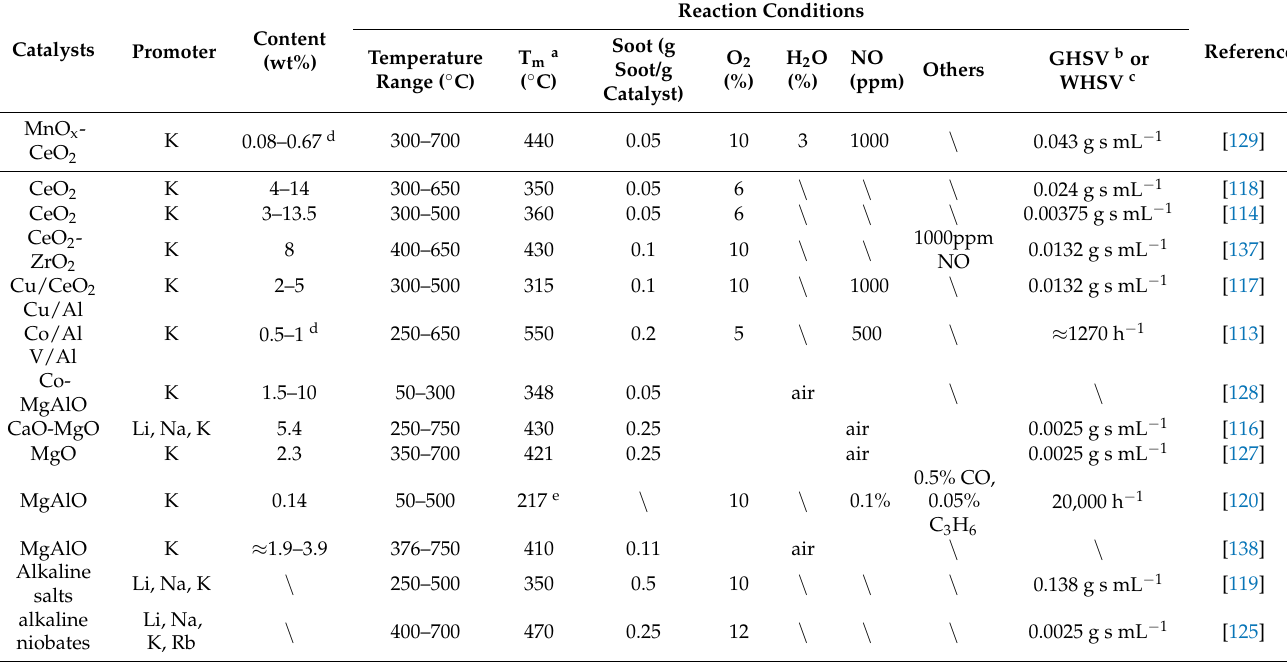
Table 6. Summary of catalysts and reaction conditions for soot oxidation catalysts promoted by alkali metals. Catalysts Promoter